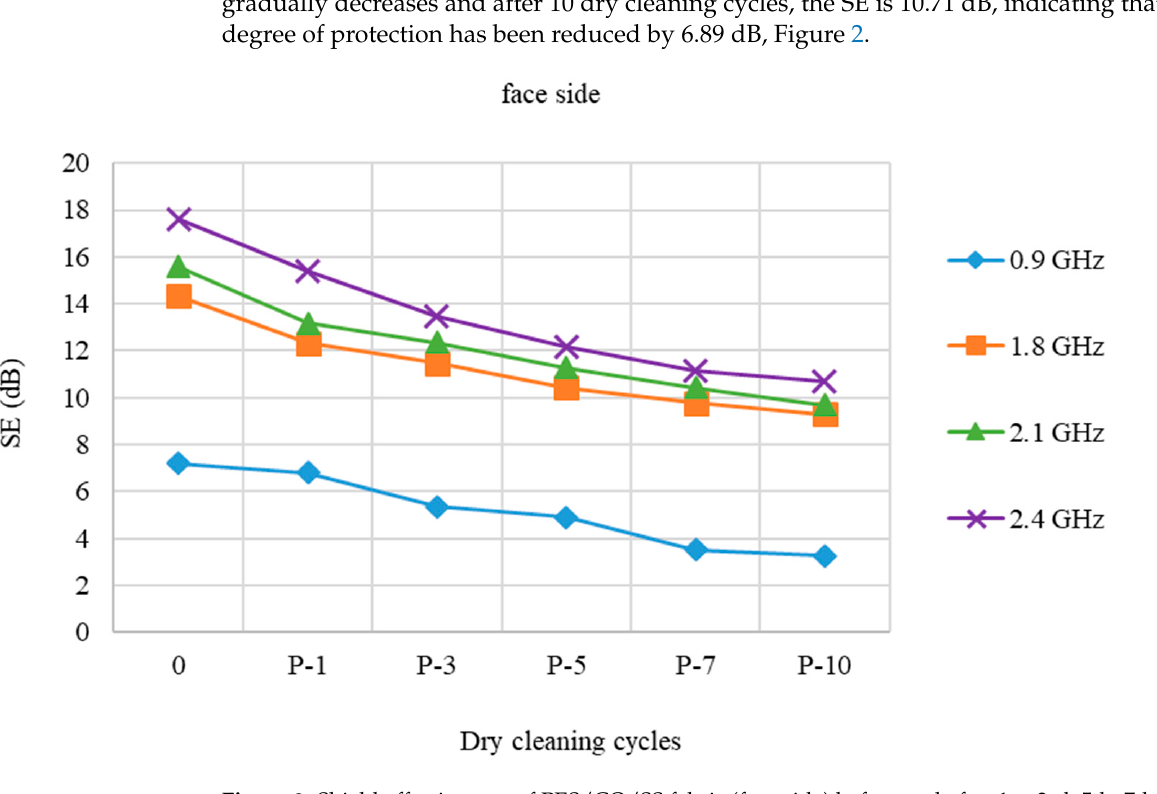
Figure 2. Shield effectiveness of PES/CO/SS fabric (face side) before and after 1st, 3rd, 5th, 7th, and 10th dry cleaning cycle (P) at frequencies 0.9 GHz, 1.8 GHz, 2.1 GHz, and 2.4GHz.